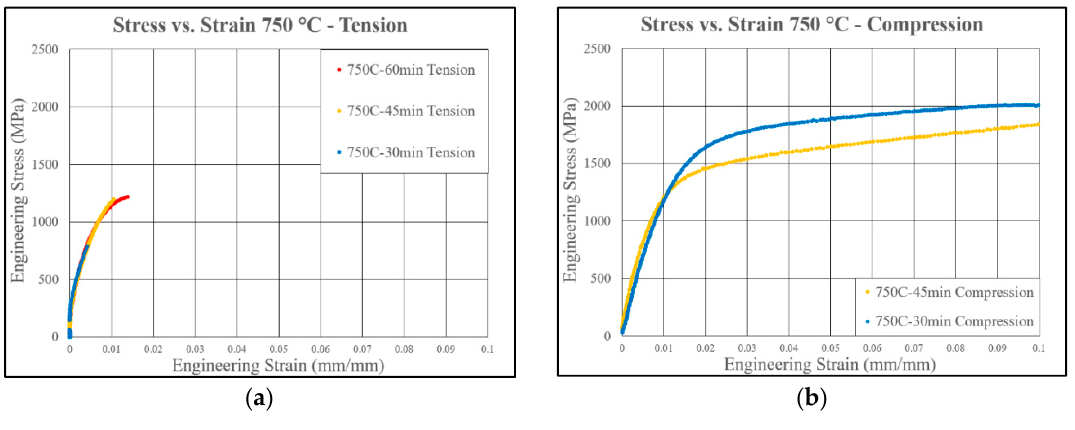
Figure 4. Tensile ( a ) and compressive ( b ) stress vs. strain results of FAST consolidation of Fe 91 -Ni 8 -Zr 1 samples. All samples were tested at room temperature, ~25 °C, with tensile and compression strain rates